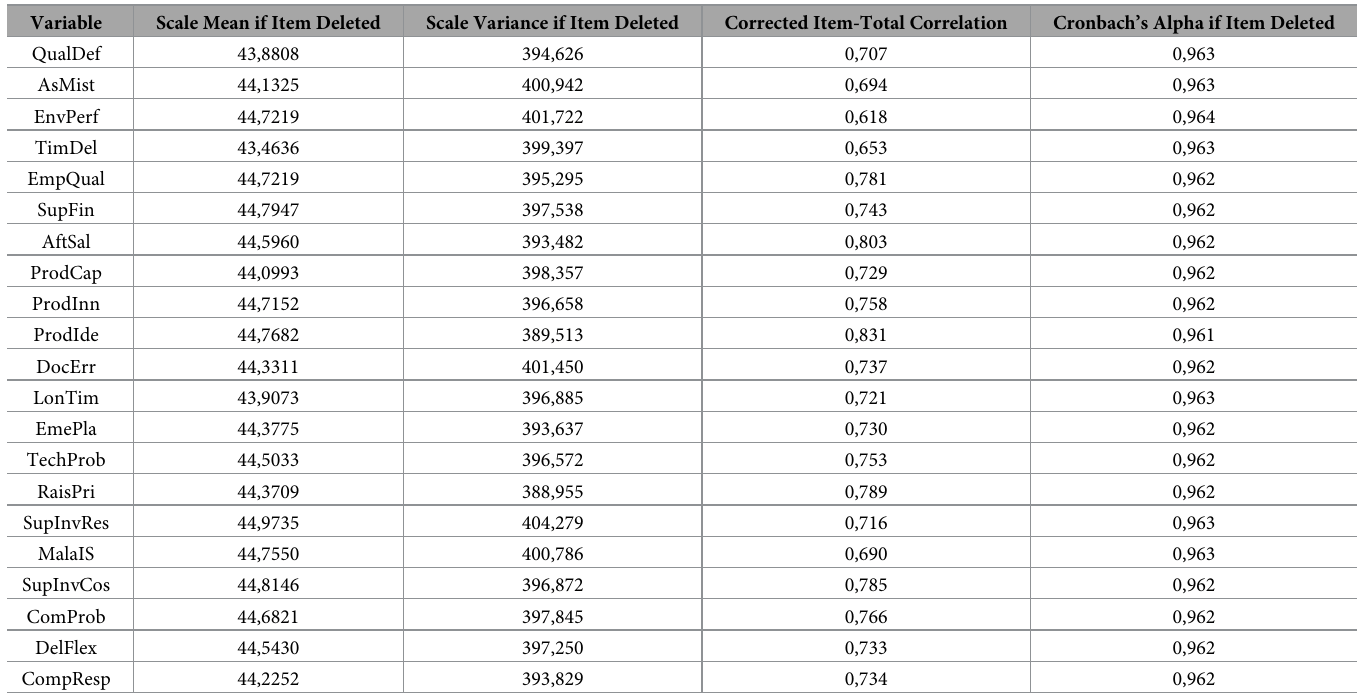
Table 2. Testing of reliability if Item